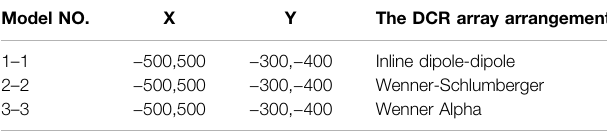
TABLE2| ThemodelparametersofvariousDCRarrayarrangementsthatneedto be compared in this group. Model